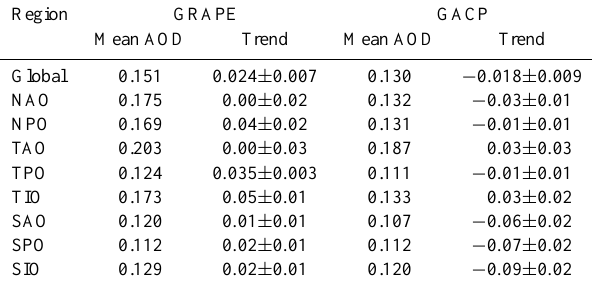
Fig. Fig. 8. The extent of the regions used in the time-series analysis. The regions are defined as follows: